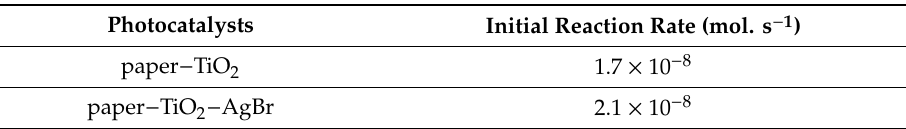
Table 1. 2-Propanol initial reaction rate calculated for the di ff erent photocatalysts was tested. Figure 7. Photodegradation of 2-propanol and formation of acetone and CO 2 versus irradiation